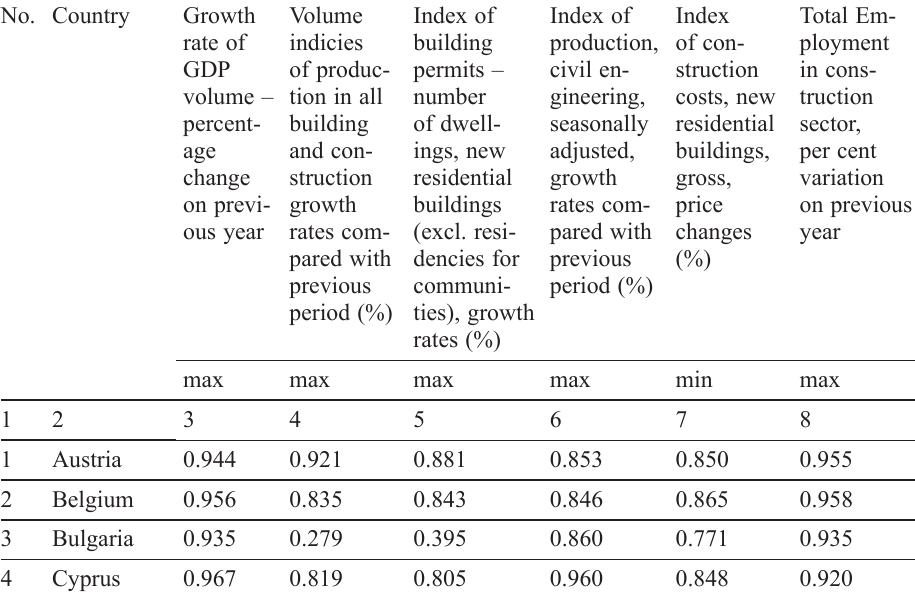
Table 3. The initial matrix without negative values P